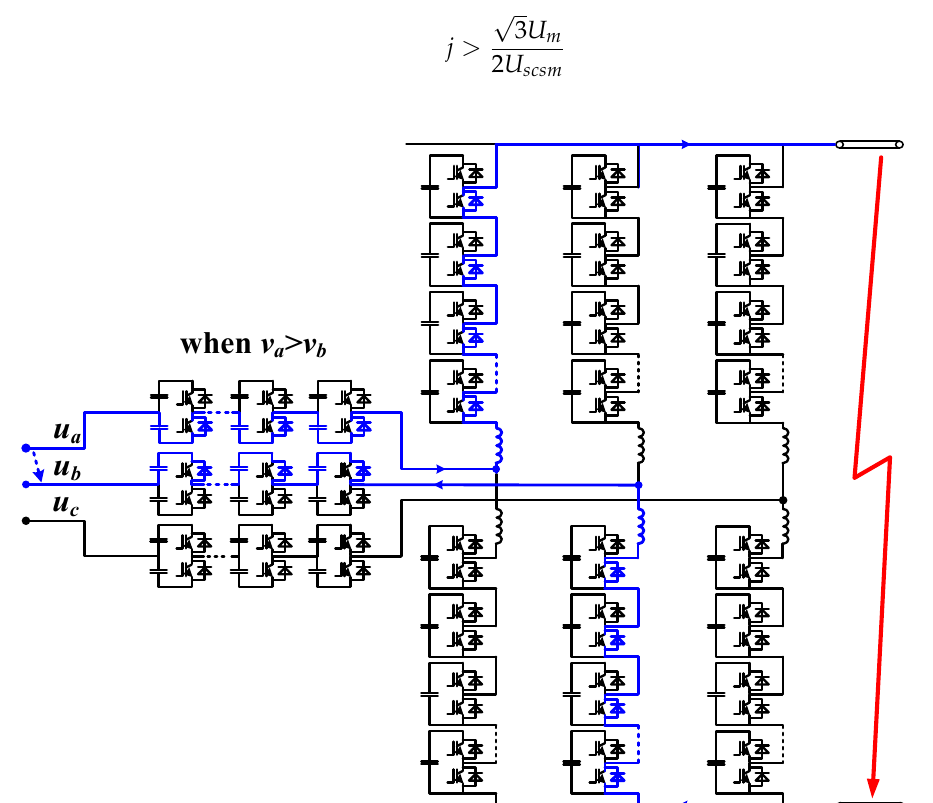
Figure 17. DC fault current route of the proposed topology when v a > v b .